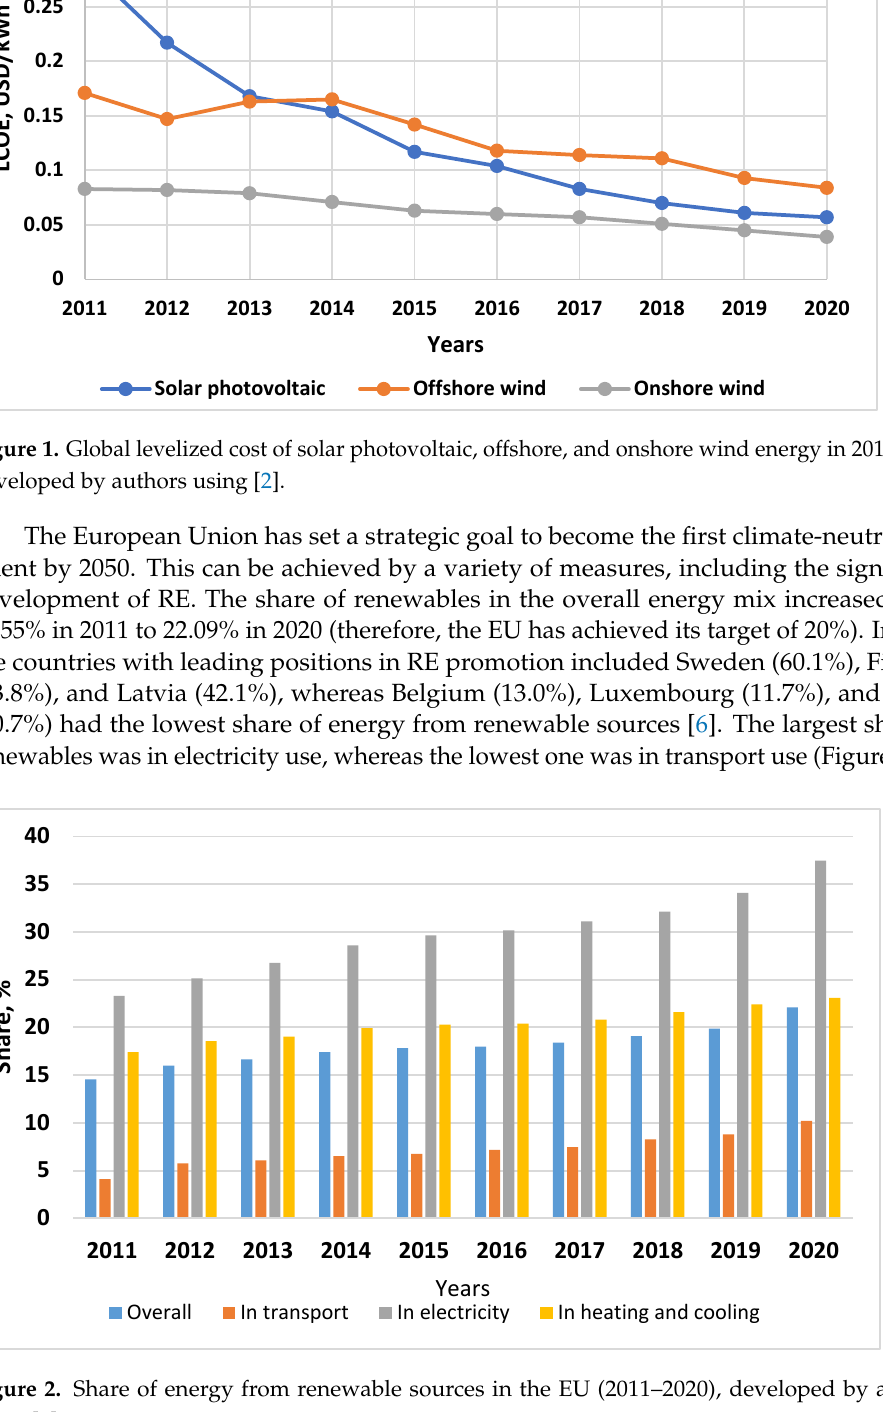
Figure 1. Global levelized cost of solar photovoltaic, offshore, and onshore wind energy in 2011– 2020, developed by authors using [2].